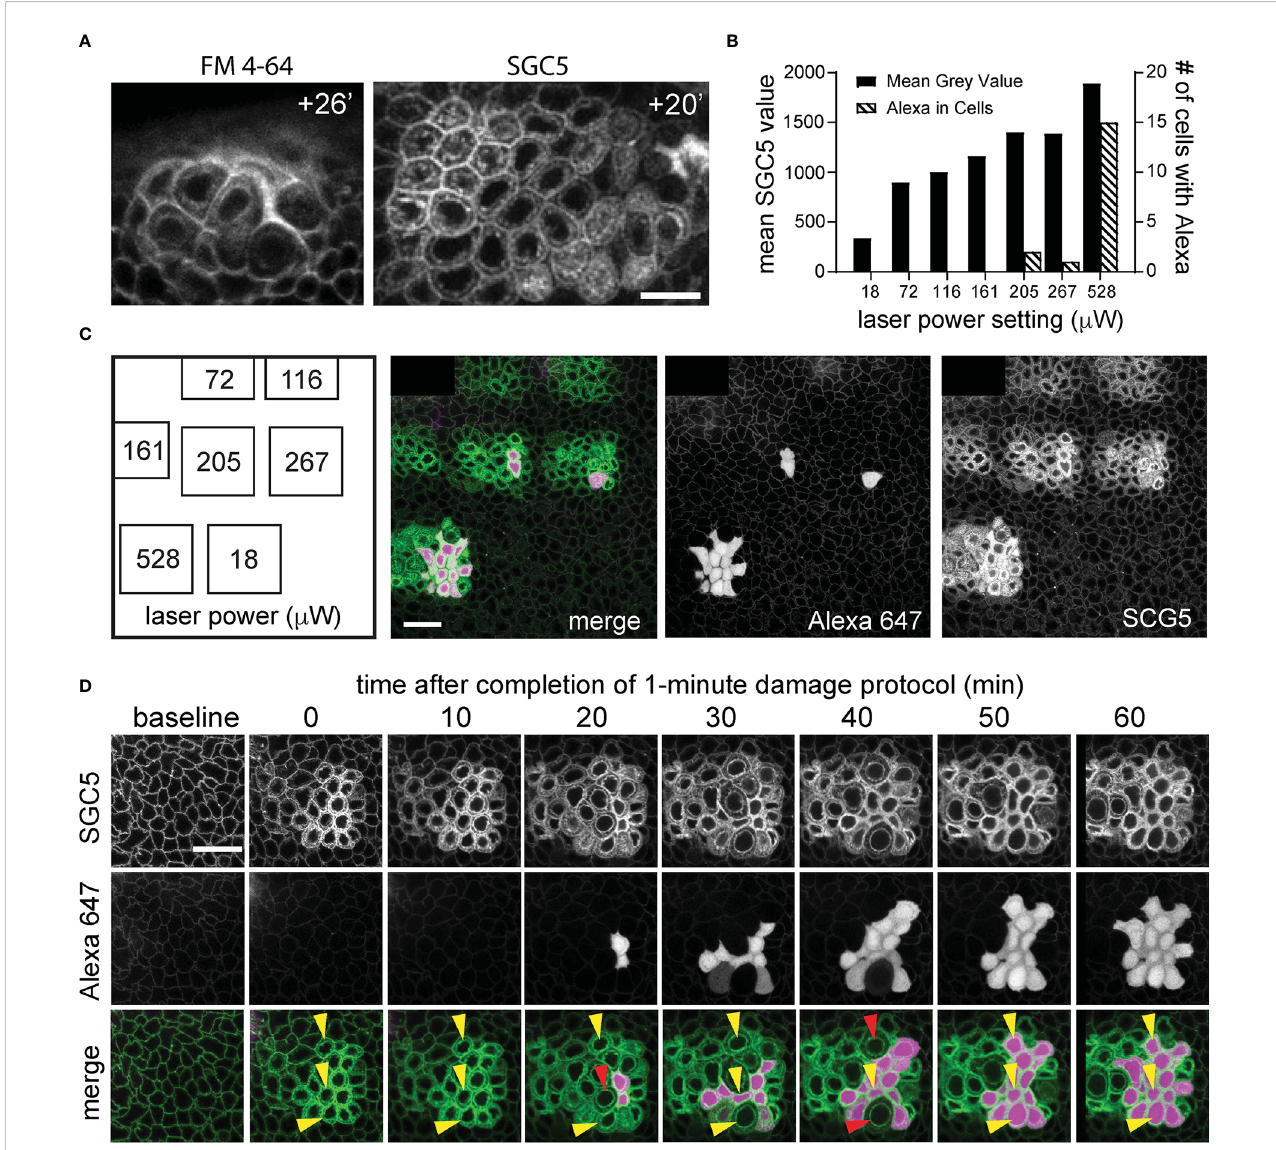
FIGURE 2 Laser power titration and Alexa 647 hydrazide dye cellular uptake following corneal basal epithelial cell microdamage. (A) Imaging of the basal epithelium injected with FM4-64 or SGC5 lipophilic membrane dyes at times (in minutes) following confocal laser scanning microscopy-induced basal epithelial cell microdamage. (B, C) Results from a single experiment in which regions of the corneal basal epithelial were scanned for 1 minute with the 488 nm laser line set at the power indicated on the x-axis and imaged 1 hour later at low laser power (488 nm at 18 µW, 640 nm at <2% laser power). The graph in (B) shows quanti fi cation of the single experiment performed in panel (C) plotting the mean SGC5 fl uorescence levels above background and number of cells with Alexa 647 hydrazide cellular uptake for each of the scanned regions. (D) Time-course of corneal basal epithelium from panel (C) that was scanned at 528 m W for 1 minute at 488 nm. SGC5 dye internalization is observed immediately following the 1-minute 528 m W laser power scan and progressively increases over time as does cell swelling. Alexa 647 dye uptake was fi rst observed 20 minutes after the high-power scan in 2 cells and increased to approximately 75% of the scanned cells after 1 hour. Three different cells are labelled with yellow arrowheads and show maximal cell swelling at time points indicated by the red arrowheads and followed at the next time point by cell contraction and Alexa 647 hydrazide uptake. Scale bars in (A, C, D) = 15